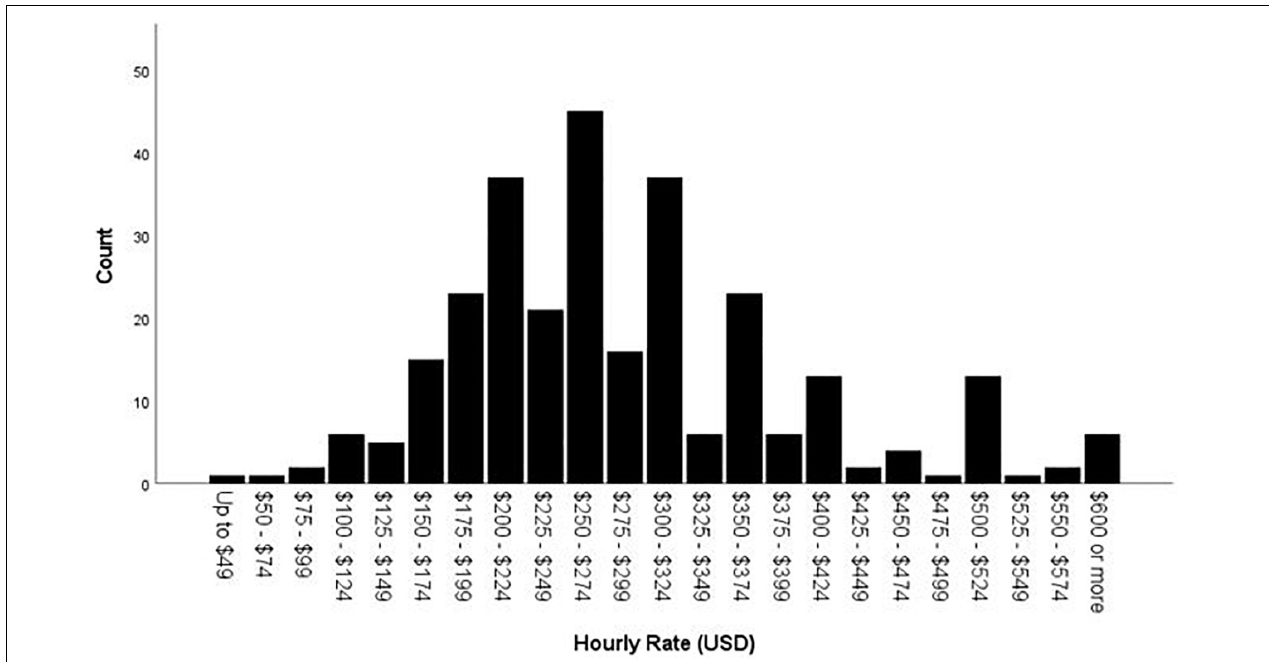
FIGURE 1 | Aggregate hourly rate (USD).